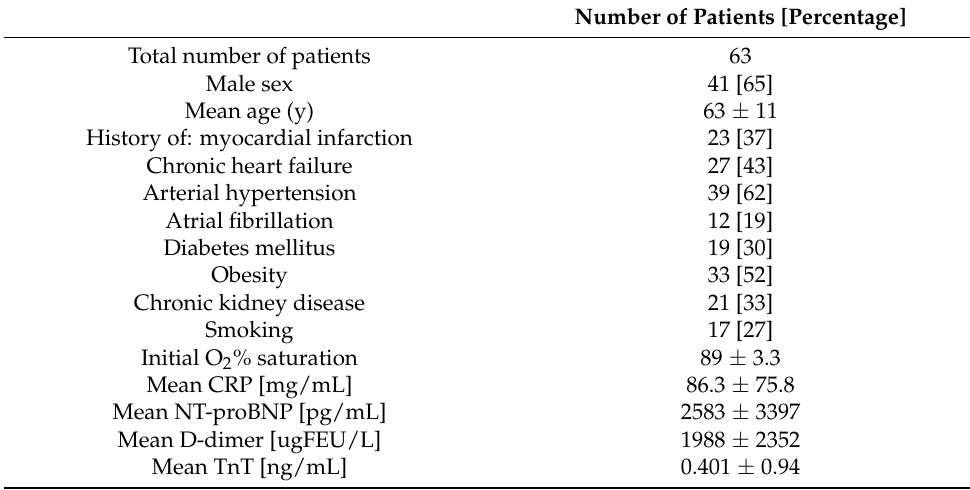
Table 1. Characteristics of study population.